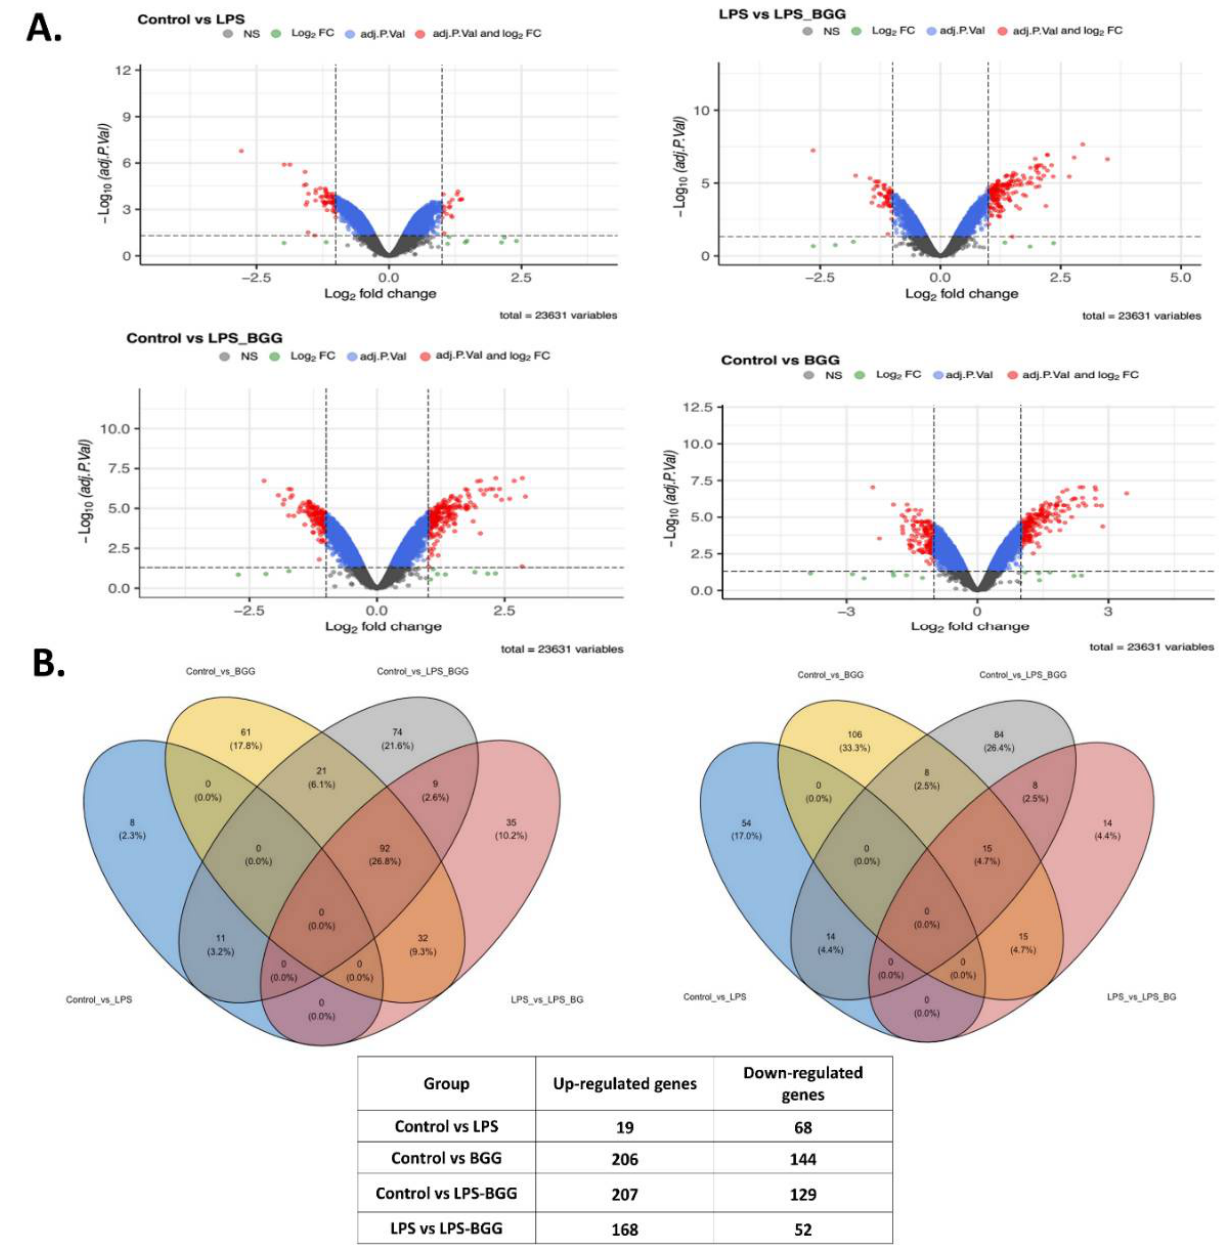
Figure 4. Microarray-based gene expression profiling on RAW 264.7 macrophages. ( A ) Volcano plots, represents the total number of genes found in each group (control vs. LPS, LPS vs. LPS-BGG, control vs. LPS-BGG, and control vs. BGG). ( B ) Wind diagram represents the differential expressed genes found in four groups, including the upregulated and downregulated genes.